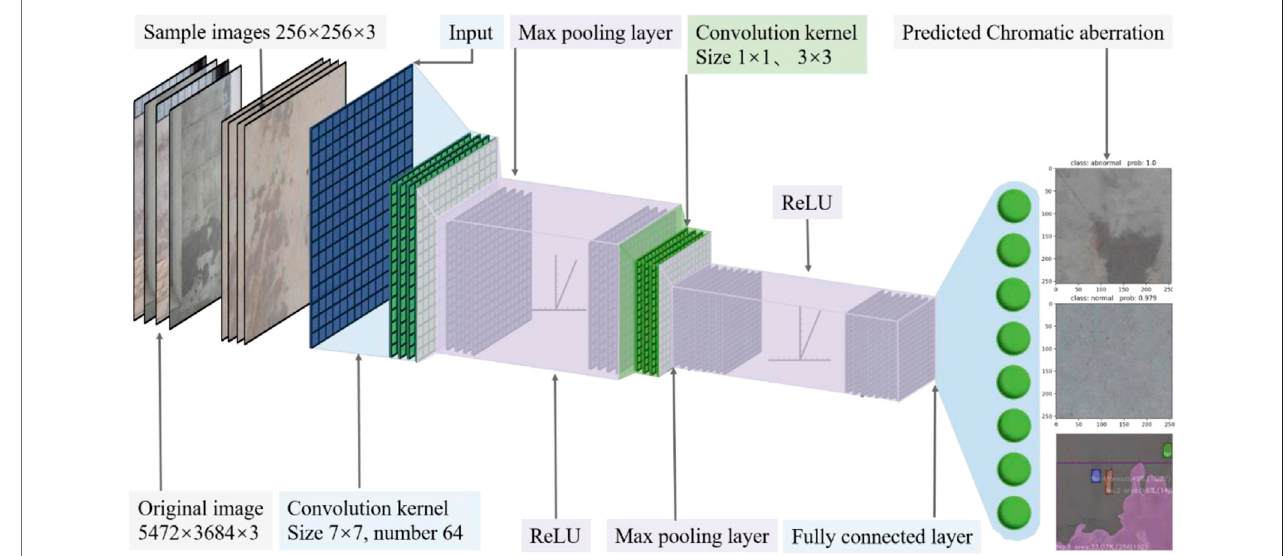
FIGURE 5 | Training process of FFC chromatic aberration experimental data in MSLSDA network.